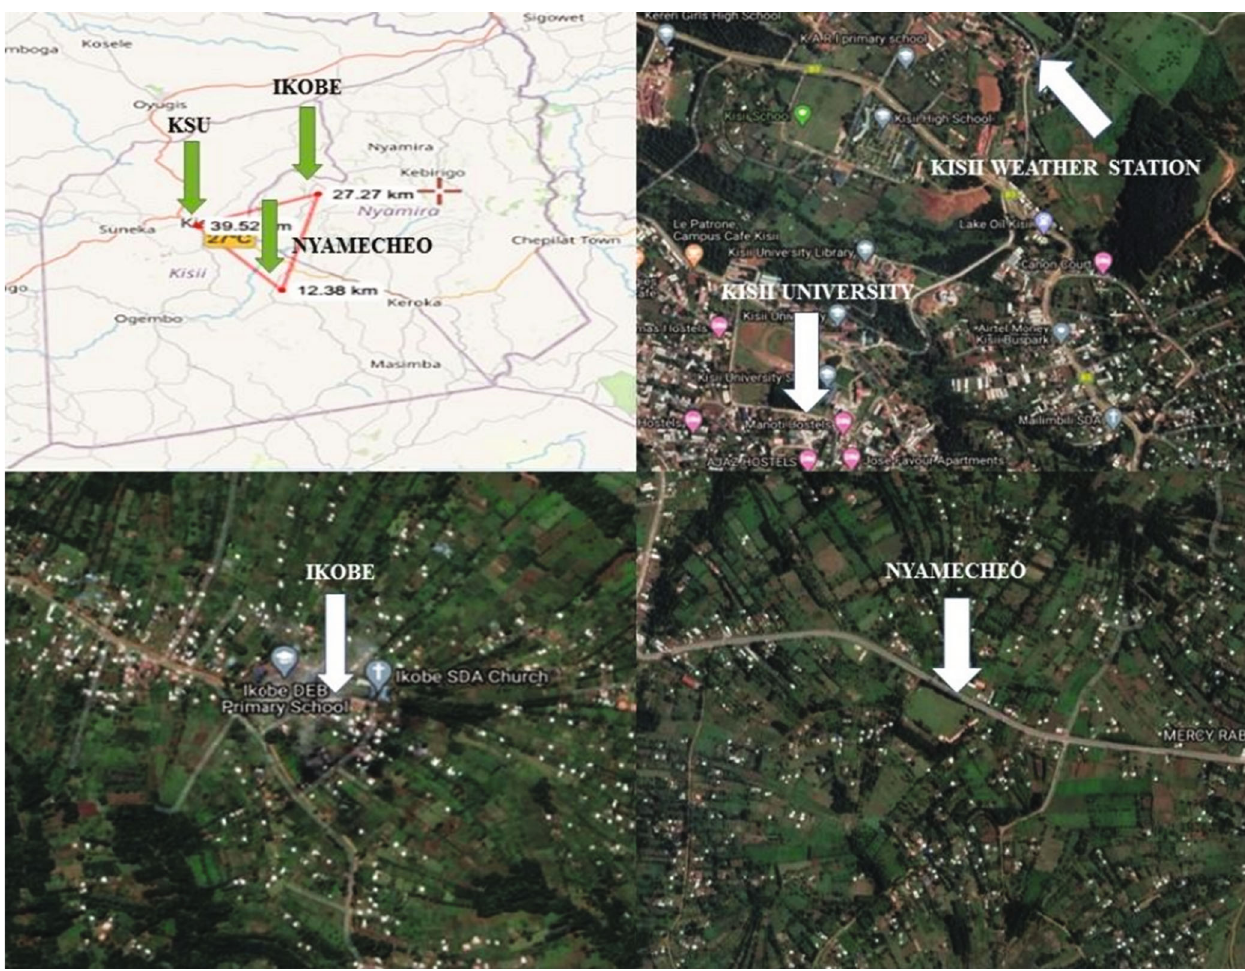
Figure 2: Map of the Kisii region and places where the research was carried out (source: